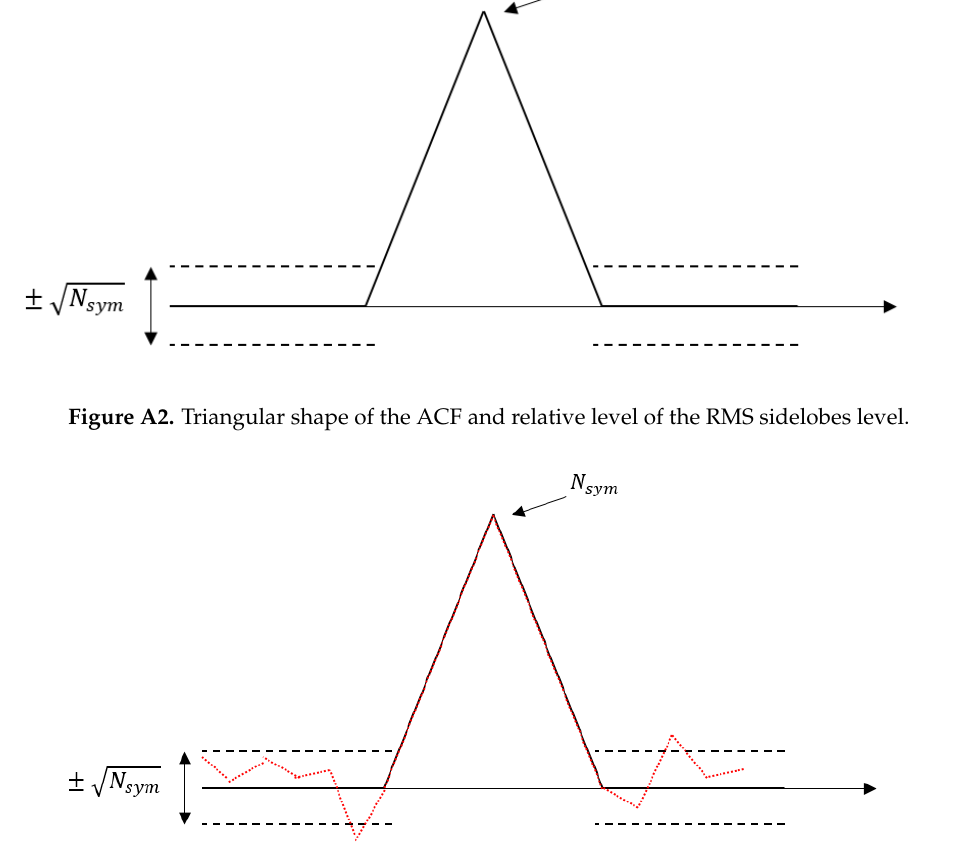
Figure A3. Example of an ACF evaluated over a limited number of samples: here, as happens on real cases, some sidelobes might overcome the RMS